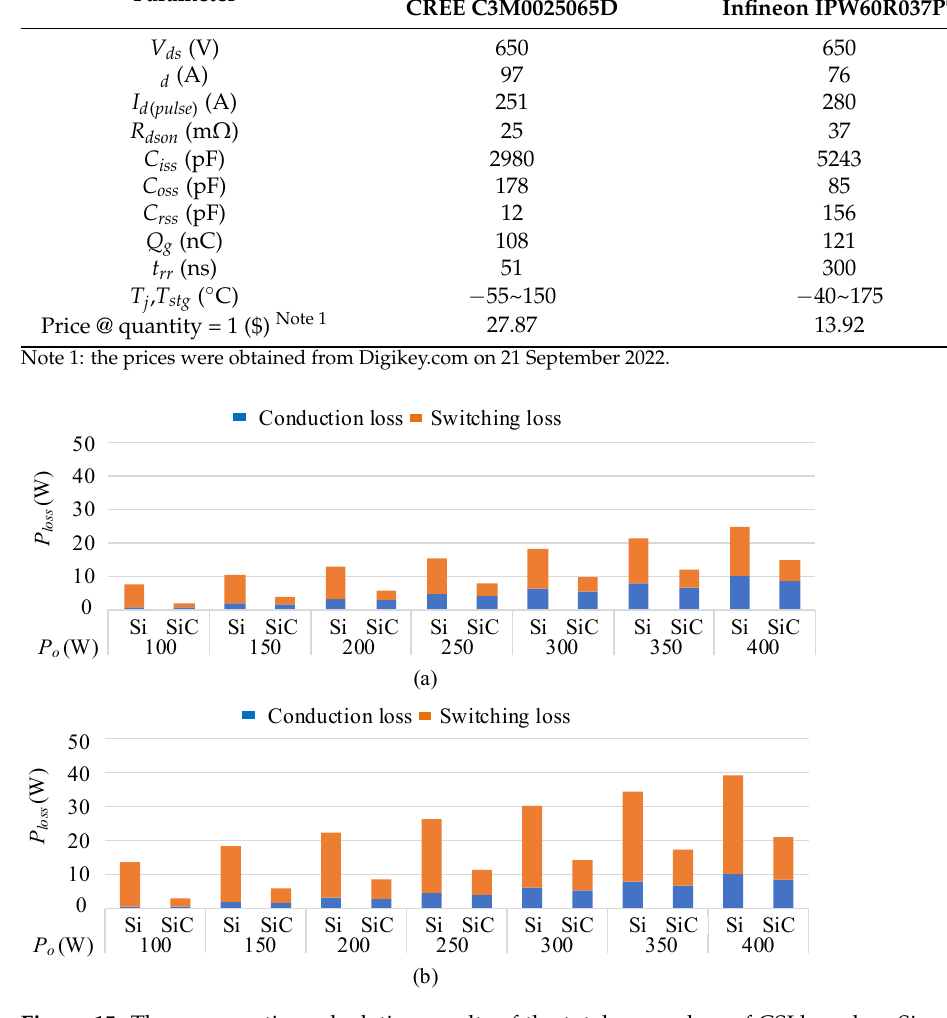
Figure 15. The comparative calculation results of the total power loss of CSI based on Si and SiC power devices: ( a ) f s = 10 kHz, and ( b ) f s = 20 kHz.